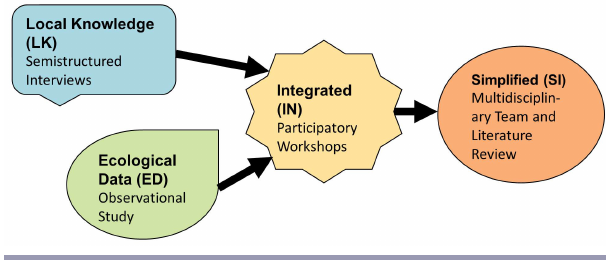
Fig. 1 . Graphical overview of the multidisciplinary state and transition model development process used for two types of land in the Elkhead Watershed, Colorado,